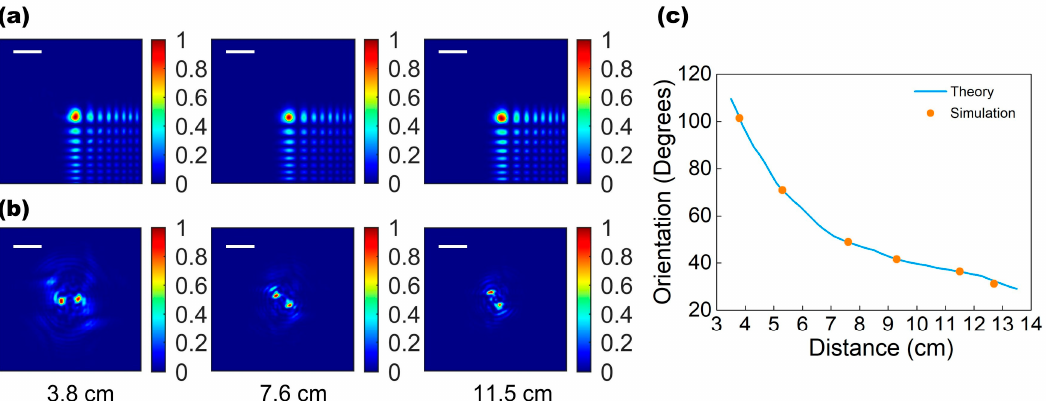
Figure 2. ( a ) Top view of the partial arrangement of GST nanorods in the designed metalens. ( b ) The magnetic field amplitude |𝐻| in the ten unit structures of C-state (upper) and A-state (lower) is distributed in the 𝑋 − 𝑍 plane at 1550 nm and TM polarization. Their period is 0.8 μm , and ℎ = 1.6 μm . The side lengths of these nanorods from left to right are 0.252 μm , 0.304 μm, 0.344 μm, 0.398 μm, 0.408 μm, 0.414 μm, 0.418 μm, 0.420 μm, 0.422 μm, and 0.488 μm, respectively. In ( c , d ), they have shown the actual phase distribution of the whole EDOF metalens in A-state and C-state, respectively. The size of the metalens is 1 mm × 1 mm .